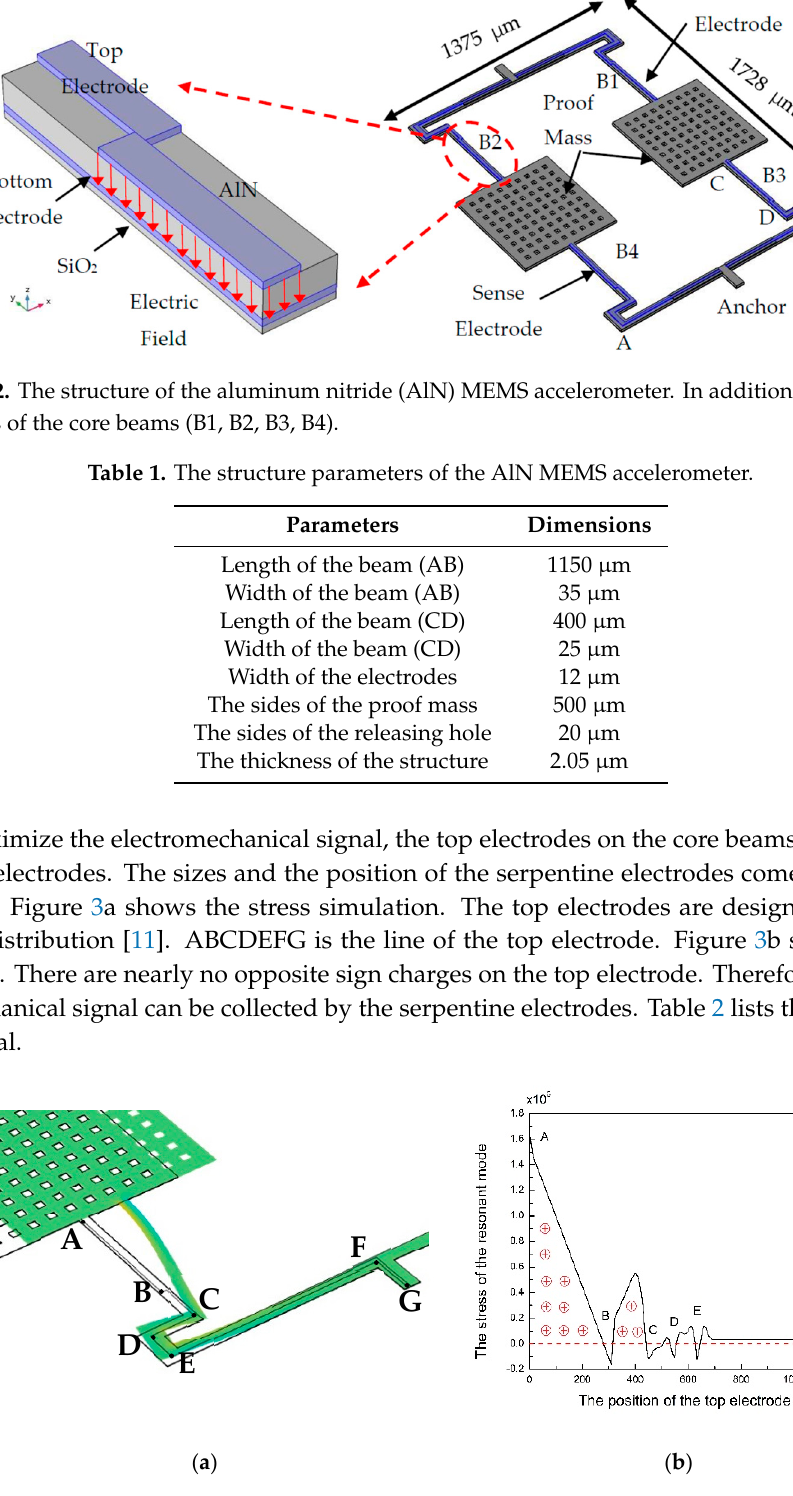
Figure 3. The stress simulation of the AlN MEMS accelerometer ( a ); the stress distribution along the top electrode ( b ).